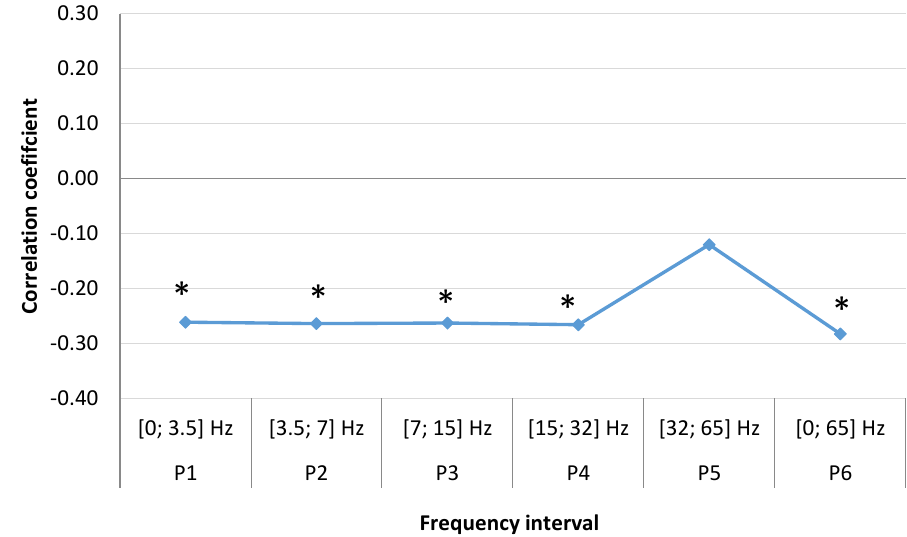
Figure 6. Correlation between men’s weekly MI number and mean magnetic power in different frequency ranges spanning a time of one week (data from LUHS, Cardiology clinic, 2016), * p < 0.05.